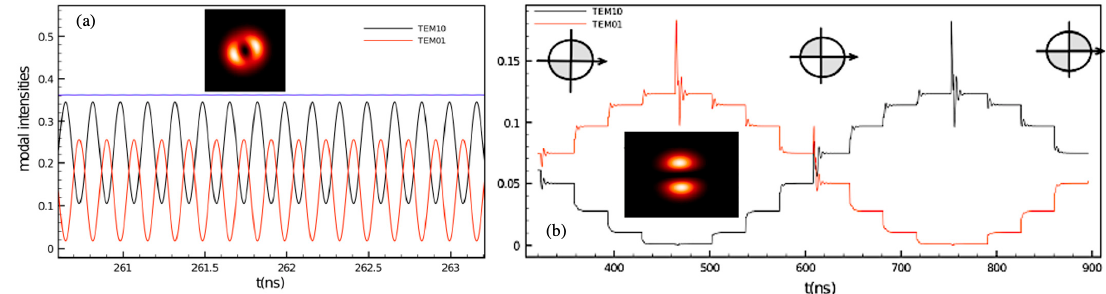
Figure 2. ( a ) Left: Temporal evolution of the modal intensities of the TEM10 and TEM01 modes of free-running VCSEL. The blue trace represents the sum of the modal intensities. ( b ) Time plot of the modal intensities during a feedback mask rotation from Θ = 0 (left inset mask) to Θ = π (right inset mask). The insets show image plots of the numerical simulation of the field intensity variation (adapted from Ref. [26]).